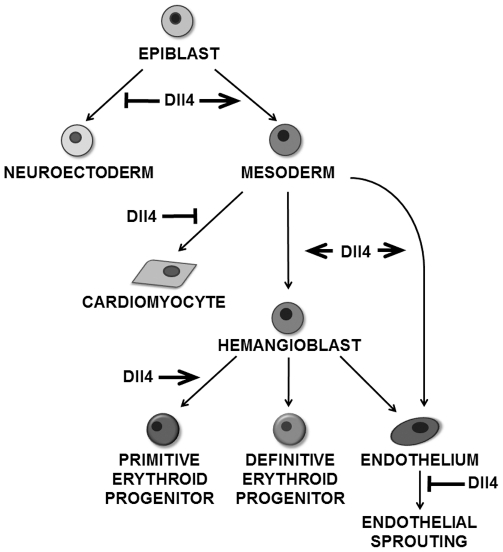
Model for Dll4 influence on ES cell differentiation.Model depicting the role of Dll4 at multiple stages of ES cell differentiation.